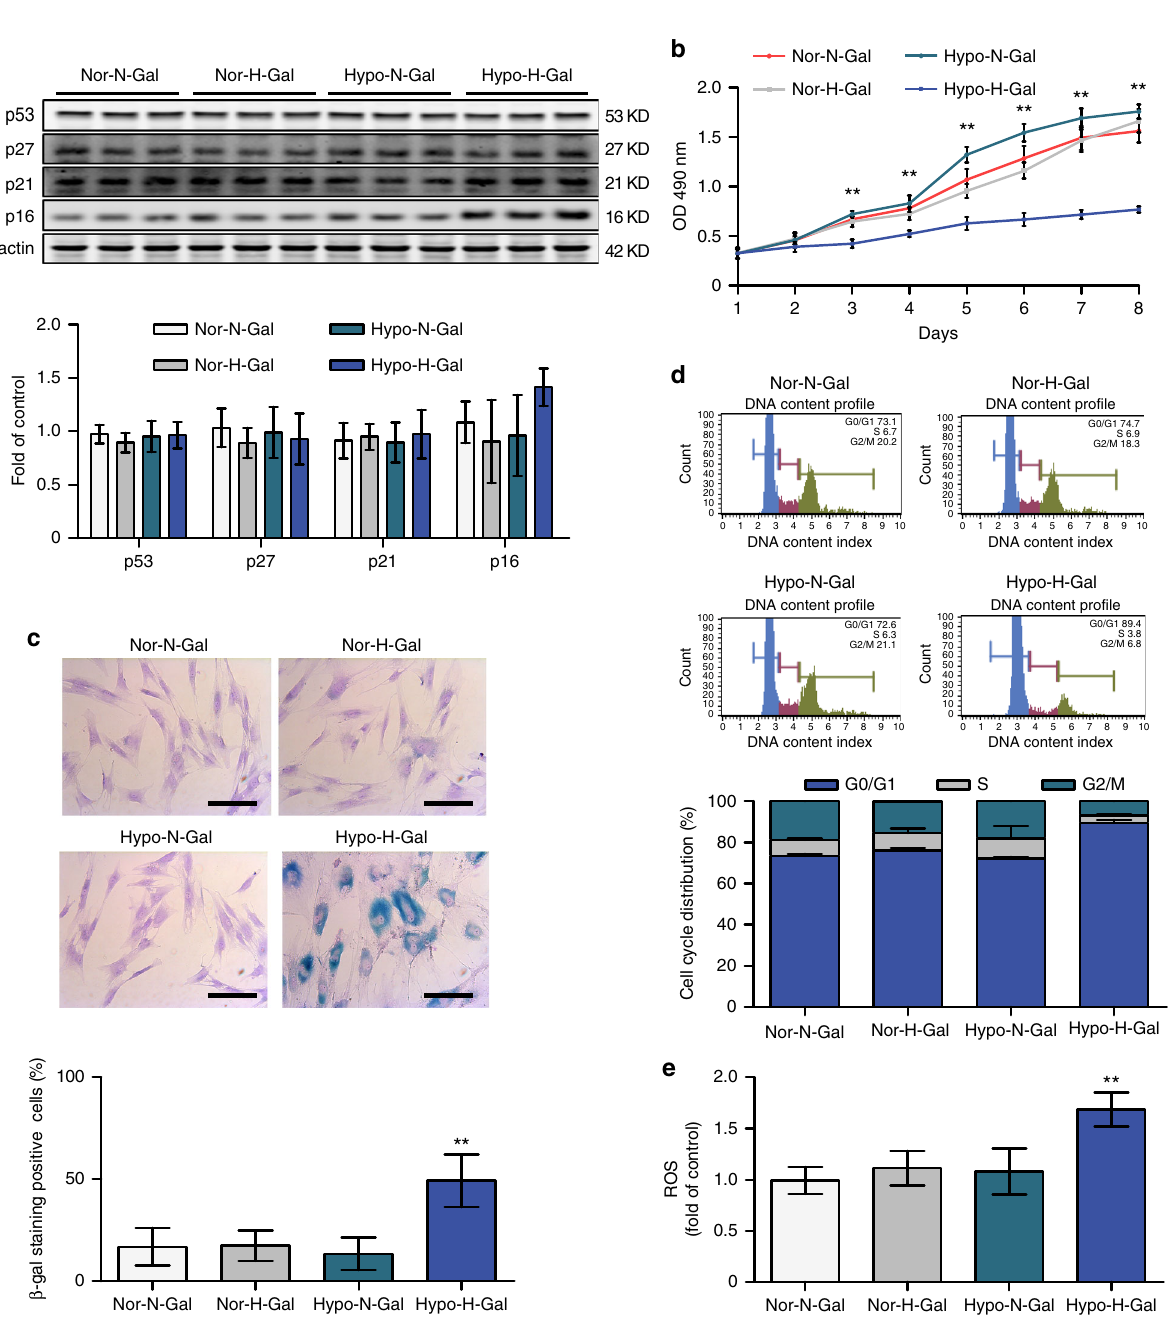
Fig. 3 D -galactose accumulation and hypoxia led to premature senescence of BMSCs. a BMSCs from patients exposed to normal (50 μ g/ml) or high (90 μ g/ml) concentrations of D -galactose and cultured in a hypoxic (4% O 2 ) or normoxic (21% O 2 ) incubator. Samples were designated Hypo-N-Gal, Hypo-H- Gal, Nor-N-Gal or Nor-H-Gal accordingly. Cell lysates were subjected to western blot analysis to assess the protein levels of p53, p27, p21, p16 and β -actin. b Cell numbers were determined by the MTT assay. c The cells described in a were subjected to SA- β -gal analysis. Scale bar, 50 μ m. d The cells described in a were subjected to FACS analysis. e Cellular ROS levels were analysed. The data shown are the mean ± SD from three independent experiments, and statistical signi fi cance was analysed by two-way ANOVA (** P < 0.01)